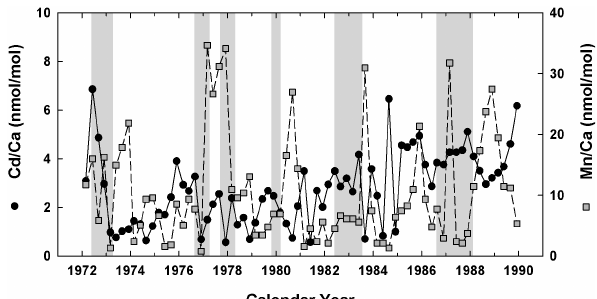
Fig. 7. Seasonal variation of the Cd/Ca ratio in Pavona gigantea for the 1972–1990 period (a) and seasonal variation of the Mn/Ca ratio in the same coral (b)